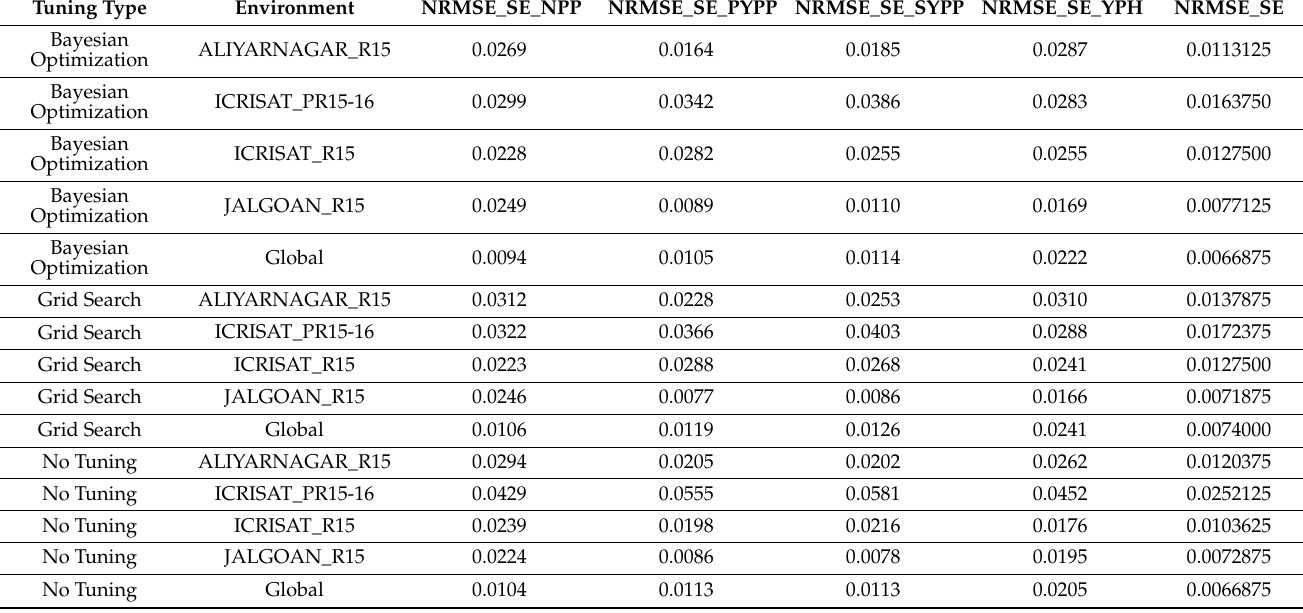
Table A6. The standard error of prediction performance for each environment and across environ- ments (Global) of the dataset 3 (Groundnut) in terms of normalized root mean square error (NRMSE) under three methods of tuning (BO, GrS and NT). RE denotes relative